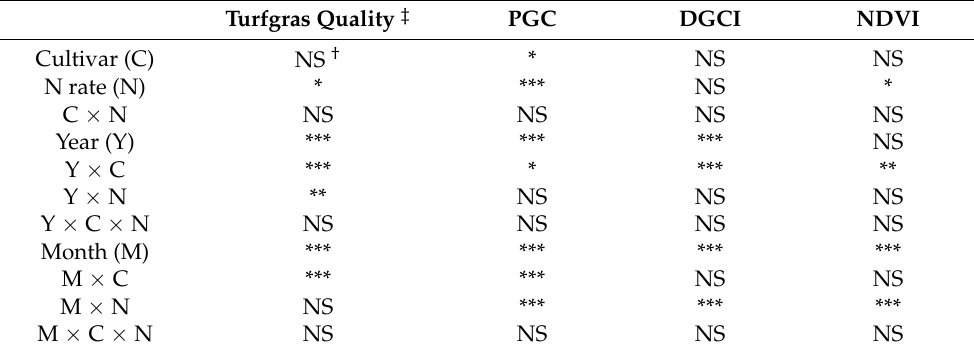
Table 2. Results of analysis of variance testing the effects of cultivar, N rate, year, and month and their interactions on turfgrass quality, percent green cover (PGC), dark green color index (DGCI), and normalized difference vegetation index (NDVI) of tall fescue ‡ .